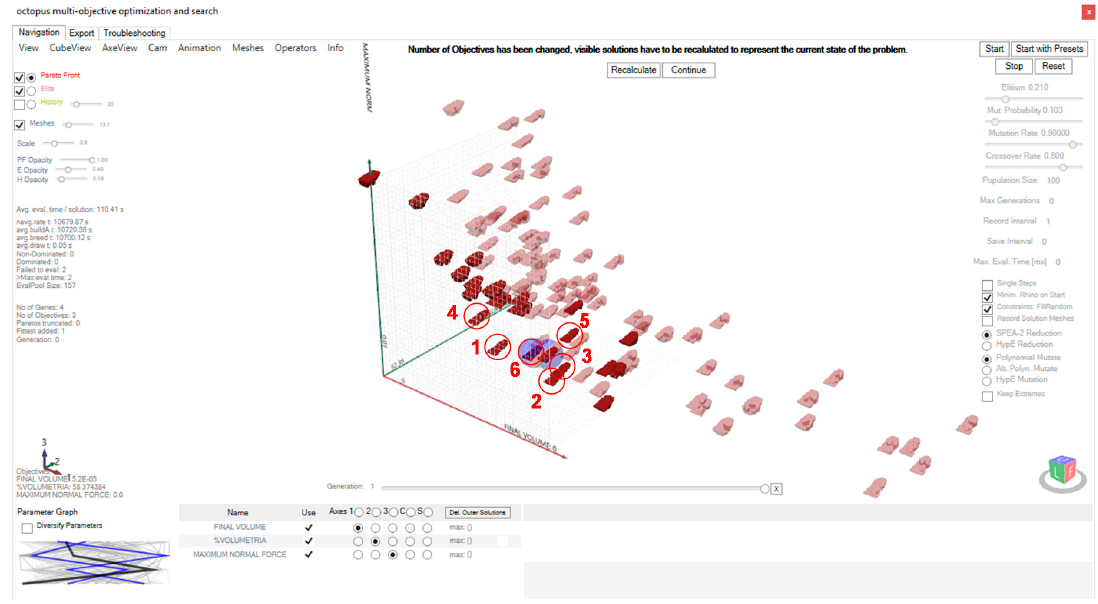
Figure 38. Selection of the 7 Pareto front solutions within the Octopus multi-objective optimization plug-in interface.